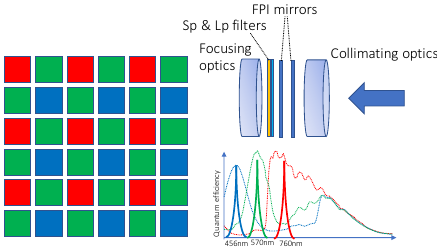
Figure 1. Working principle of Fabry-Perot interferometer.